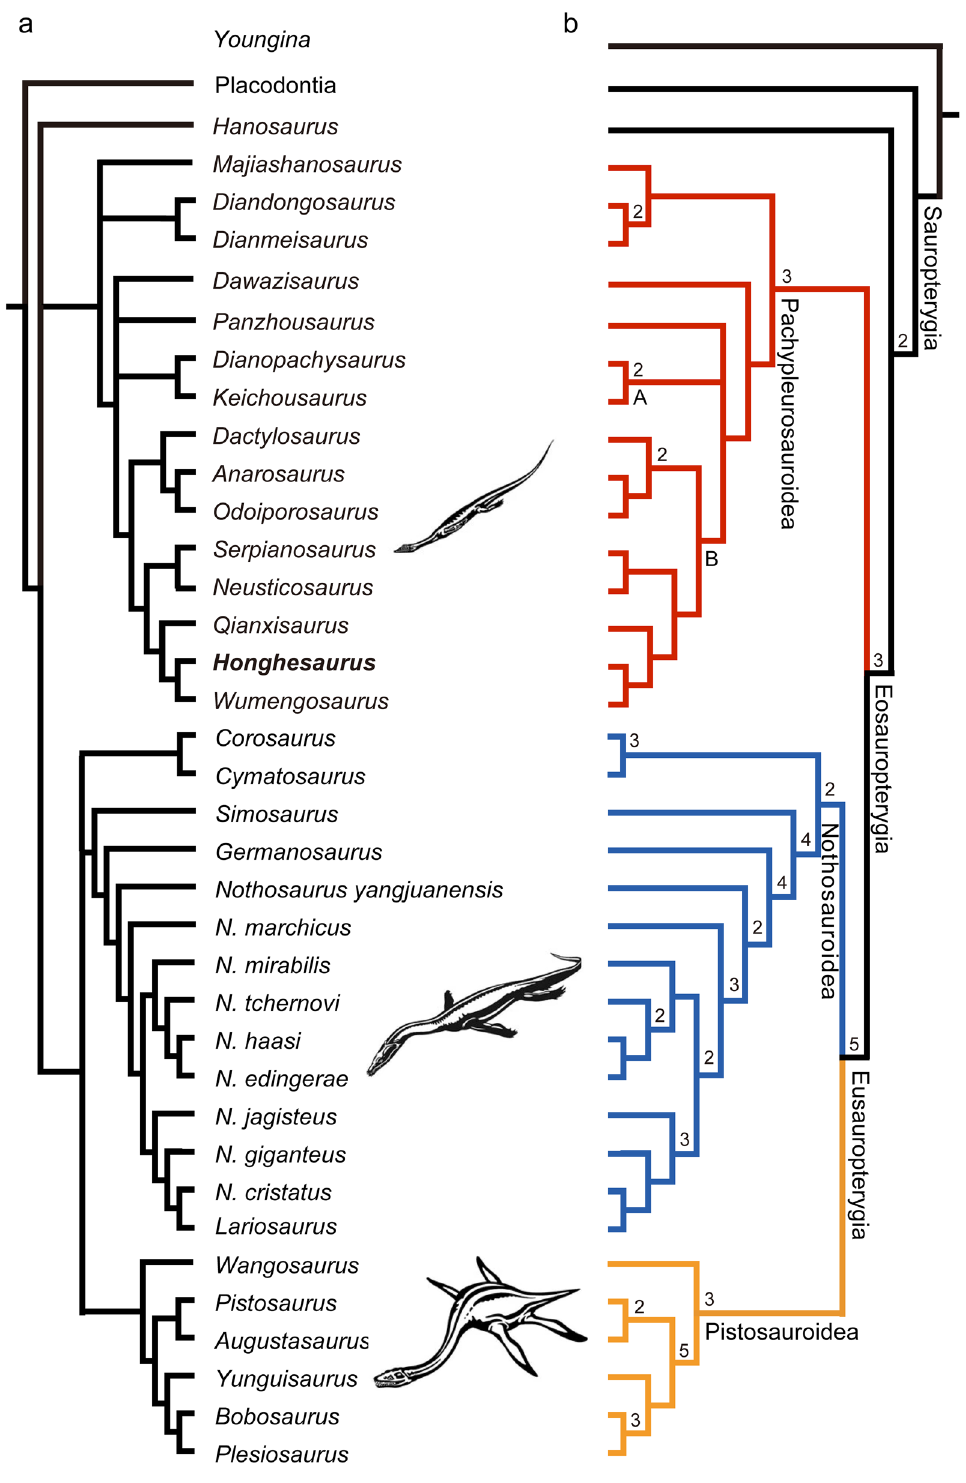
Figure 5. Phylogenetic position of Honghesaurus longicaudalis gen. et sp. nov. ( a ) Strict consensus of five trees rooted with four placodonts (TL = 686, CI = 0.3776, and RI = 0.6674). ( b ) Strict consensus of two trees rooted with Youngina (TL = 710, CI = 0.3662, and RI = 0.6649). Bremer decay indices larger than 1 are indicated above or below the nodes in tree a. Node A, Keichousauridae. Node B,